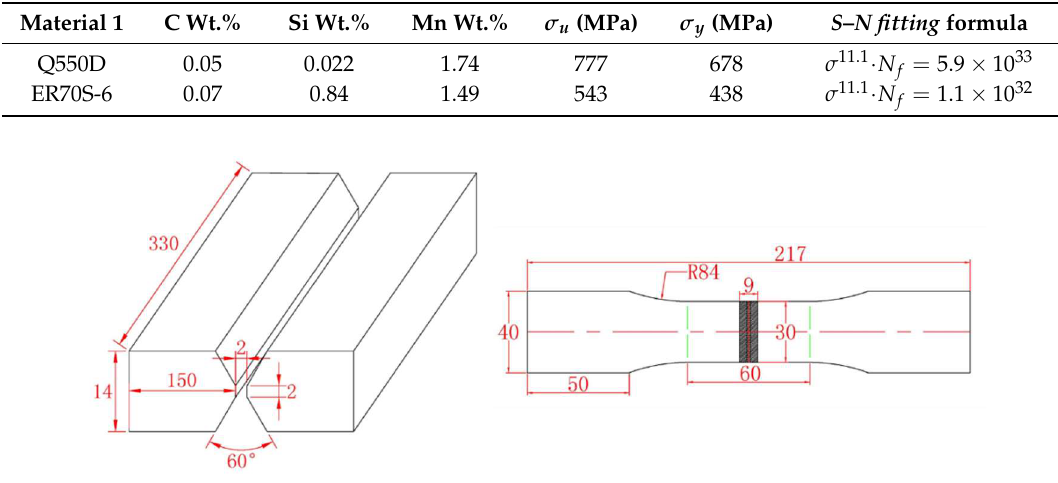
Figure 6. Geometric parameters of the base metal and the specimen of butt-welded joints. (Unit: mm).